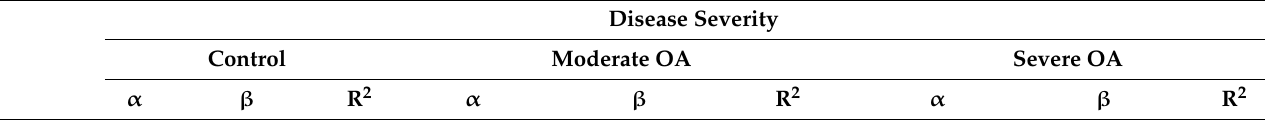
Table 2. Correlation of disease severity ( β ) and Krenn score ( α ) with expression of iNOS, BCL-2 and MMP-9 in intima and subintima of OA patients.